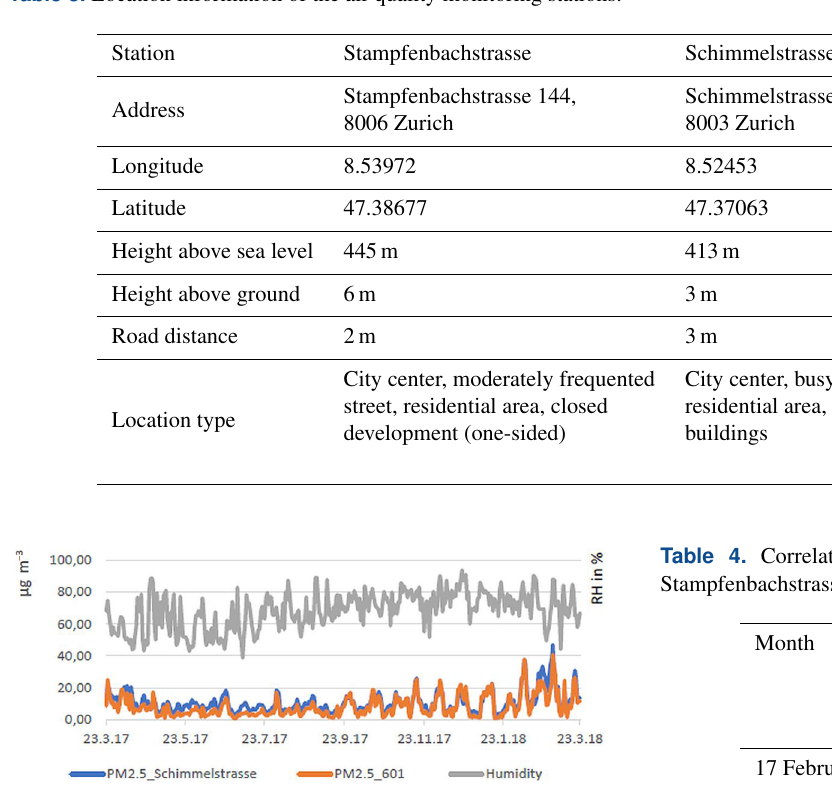
Table 3. Location information of the air quality monitoring stations.